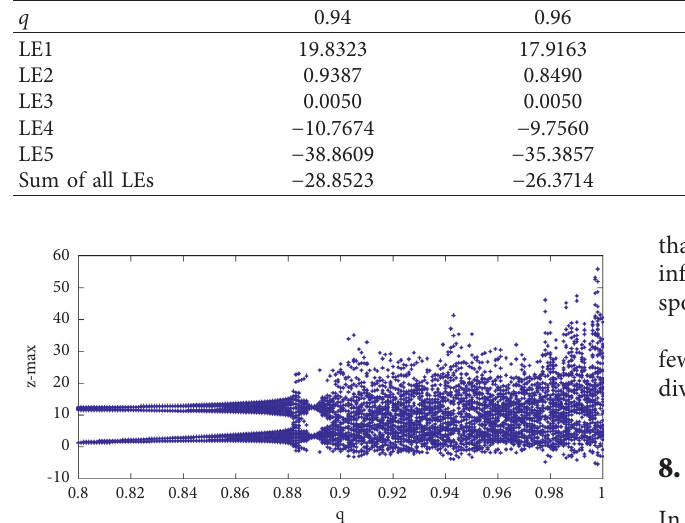
Figure 1: Bifurcation diagram for variation of the fractional de- rivative order q in the interval (0.8,